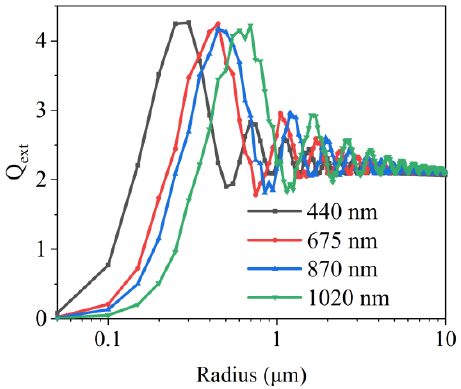
Figure A3. The 50-times calculation results of ( N , σ ).